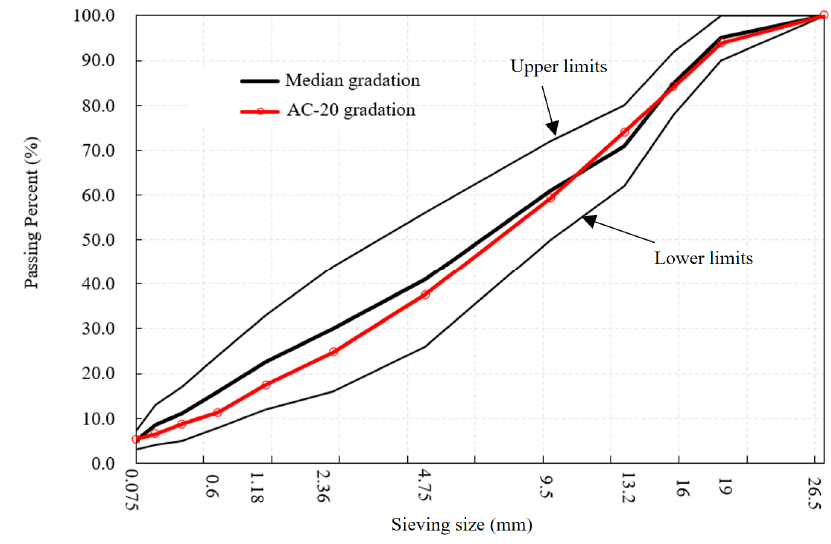
Figure 2. Gradation curve of the AC-20C mixture.